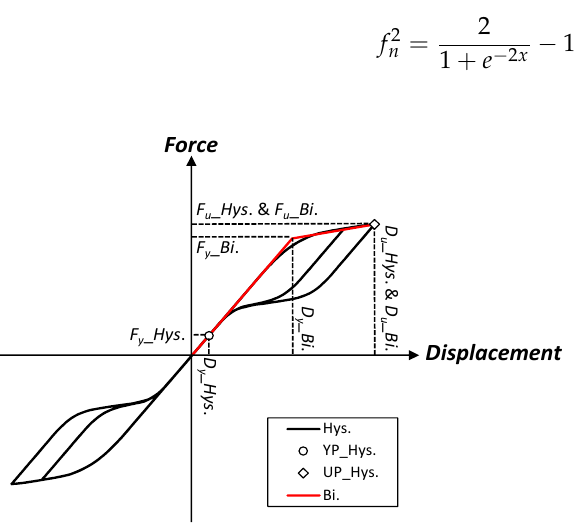
Figure 13. Idealisation of hysteresis curve using bilinear envelope curve.